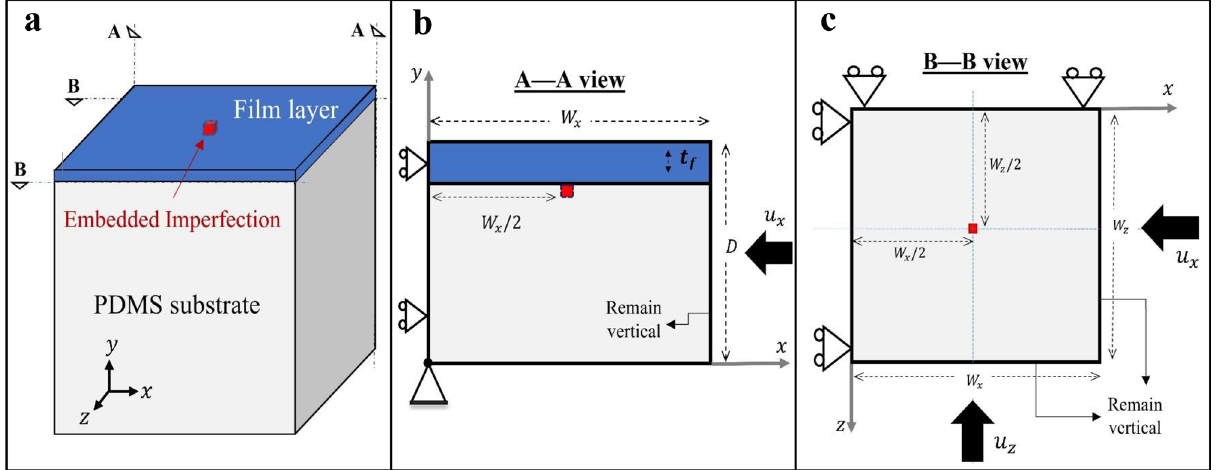
Figure 1. ( a – c ) Schematics of the problem domain, boundary conditions, and the directions of applied